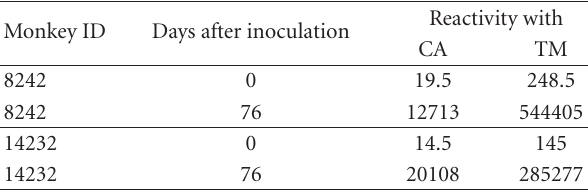
Table 2: Immunoassay of plasma from XMRV-inoculated maca-